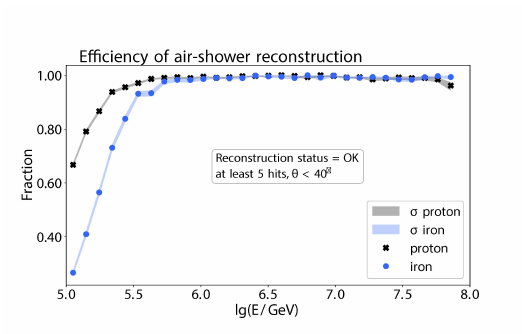
Figure 8. The e ffi ciency of reconstructing air-showers for pro- ton and iron primaries. The proposed array can reconstruct air- showers with full e ffi ciency even below 1 PeV. Still high e ffi - ciency for lower energies will improve the veto analysis for in-ice measurements.